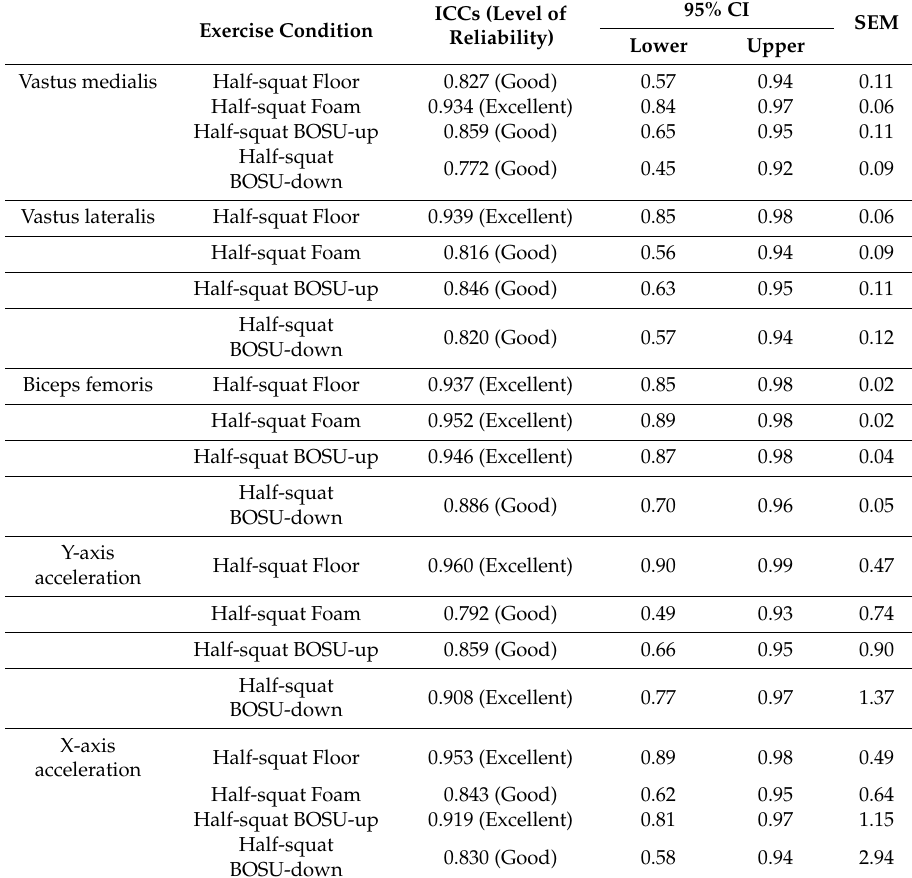
Table 1. Reliability values for each muscle analysed and body centre of mass acceleration under half-squat conditions.